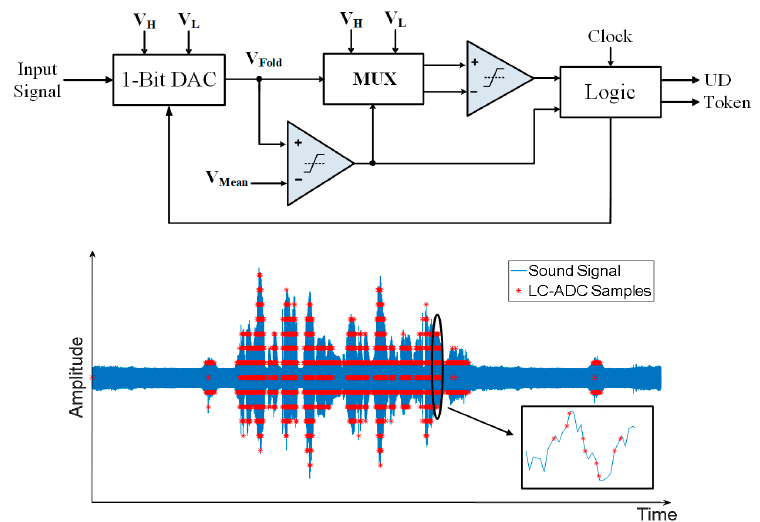
Figure 6. Block diagram of the LC-ADC, including the input signal and LC-ADC output samples.